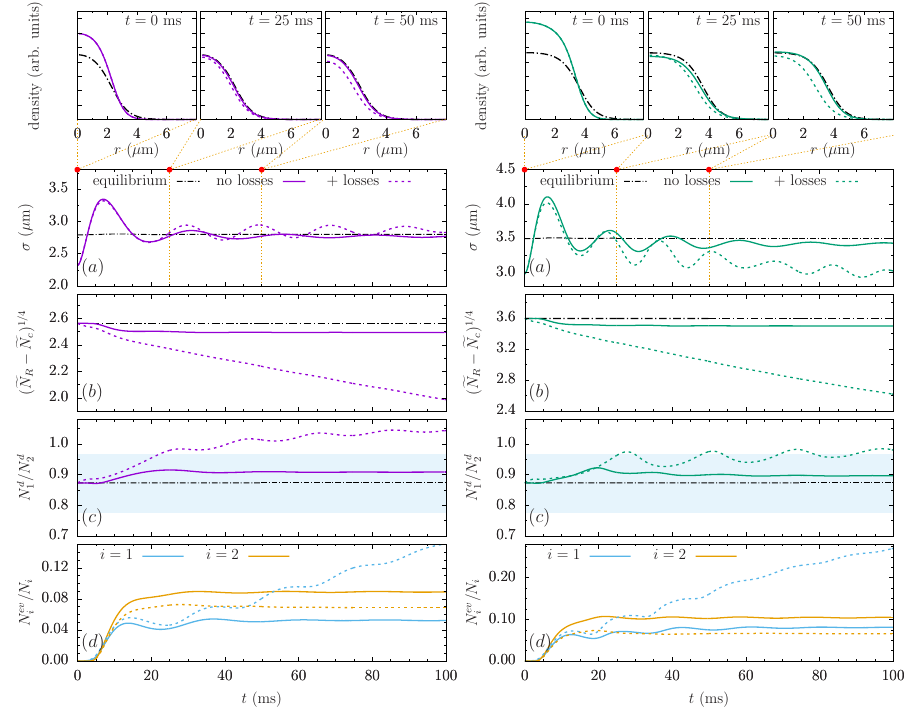
N R ( t ) (see text), ( c ) the Figure 3. Evolution of ( a ) the droplet width σ ( t ) , ( b ) the running value of ( t ) / N d ( t ) , and ( d ) the fraction of evaporated atoms for each species N ev ( t ) / N i , after the ratio N d 2 i 1 (cid:101) release from a trap of frequency ω 2 = 2 π 50 Hz, with and without three-body losses. The insets × 2 , at different N i ψ i ( r , t ) in the top row show the total density of the binary mixture, n ( r , t ) = ∑ 2 i = 1 | | evolution times, corresponding to the red circles in ( a ). The horizontal line in ( b ) represent the nominal g 22 / g 11 equilibrium value N 1 / N 2 = 0.873, and the dashed area the corresponding tolerance (cid:39) (see text). Here a 12 = 82 a 0 , N 2 = 4 10 4 (left), N 2 = 1.5 10 5 (cid:112) − × ×